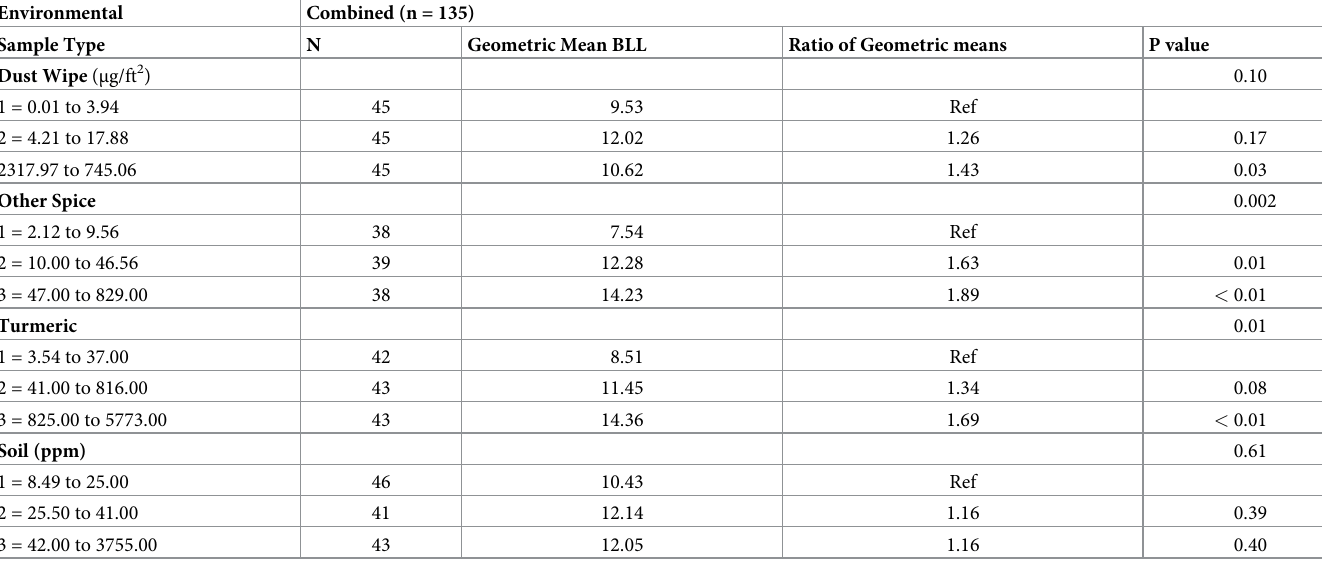
Table 9. Bivariate analysis of BLL and environmental lead levels in terciles for all children. Patna Bihar, February 2020.